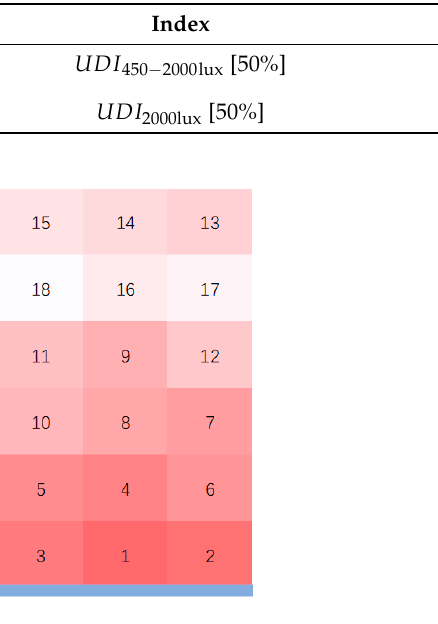
Figure 3. Prioritization of location in the small office space.